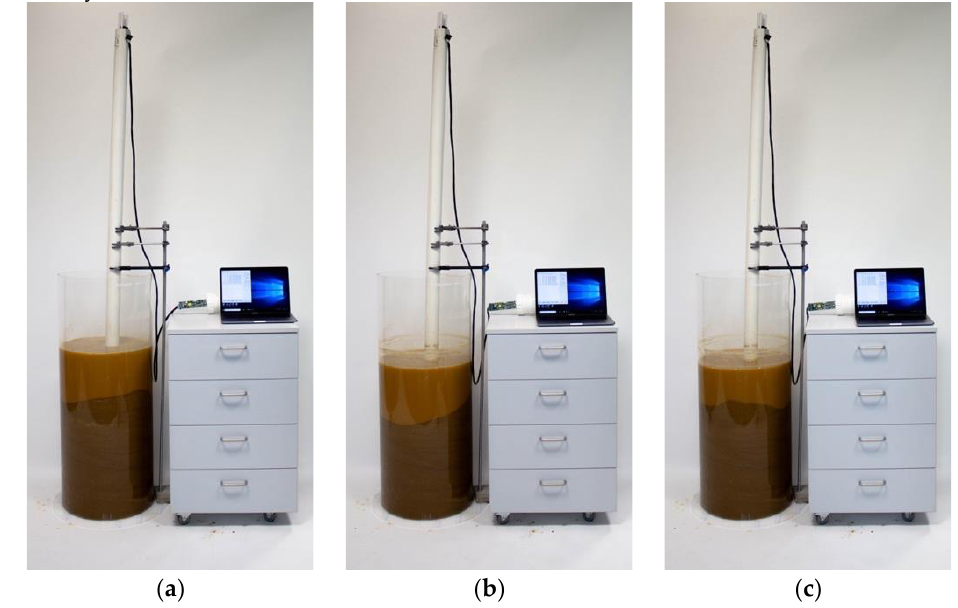
Figure 10. Static scour test showing ( a ) the pre-scour, ( b ) the scour, and ( c ) the deposition condition.